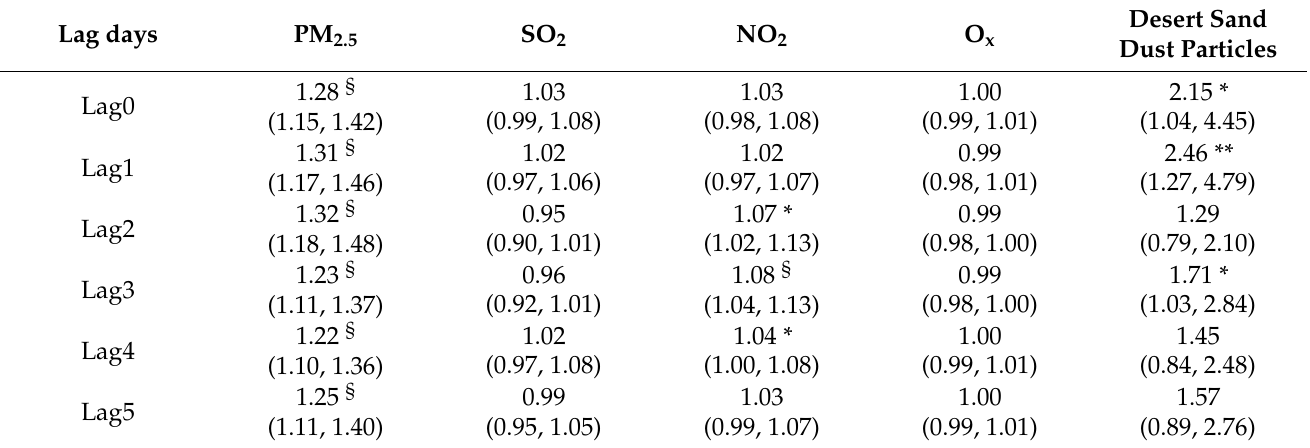
Table 4. Estimated relative risk and 95% confidence interval for overall absence from school due to sickness associated with a 10- µ g/m 3 increase in PM 2.5 , a 1-ppb in NO 2 , SO 2 and O x and a 0.1-km − 1 in desert sand dust